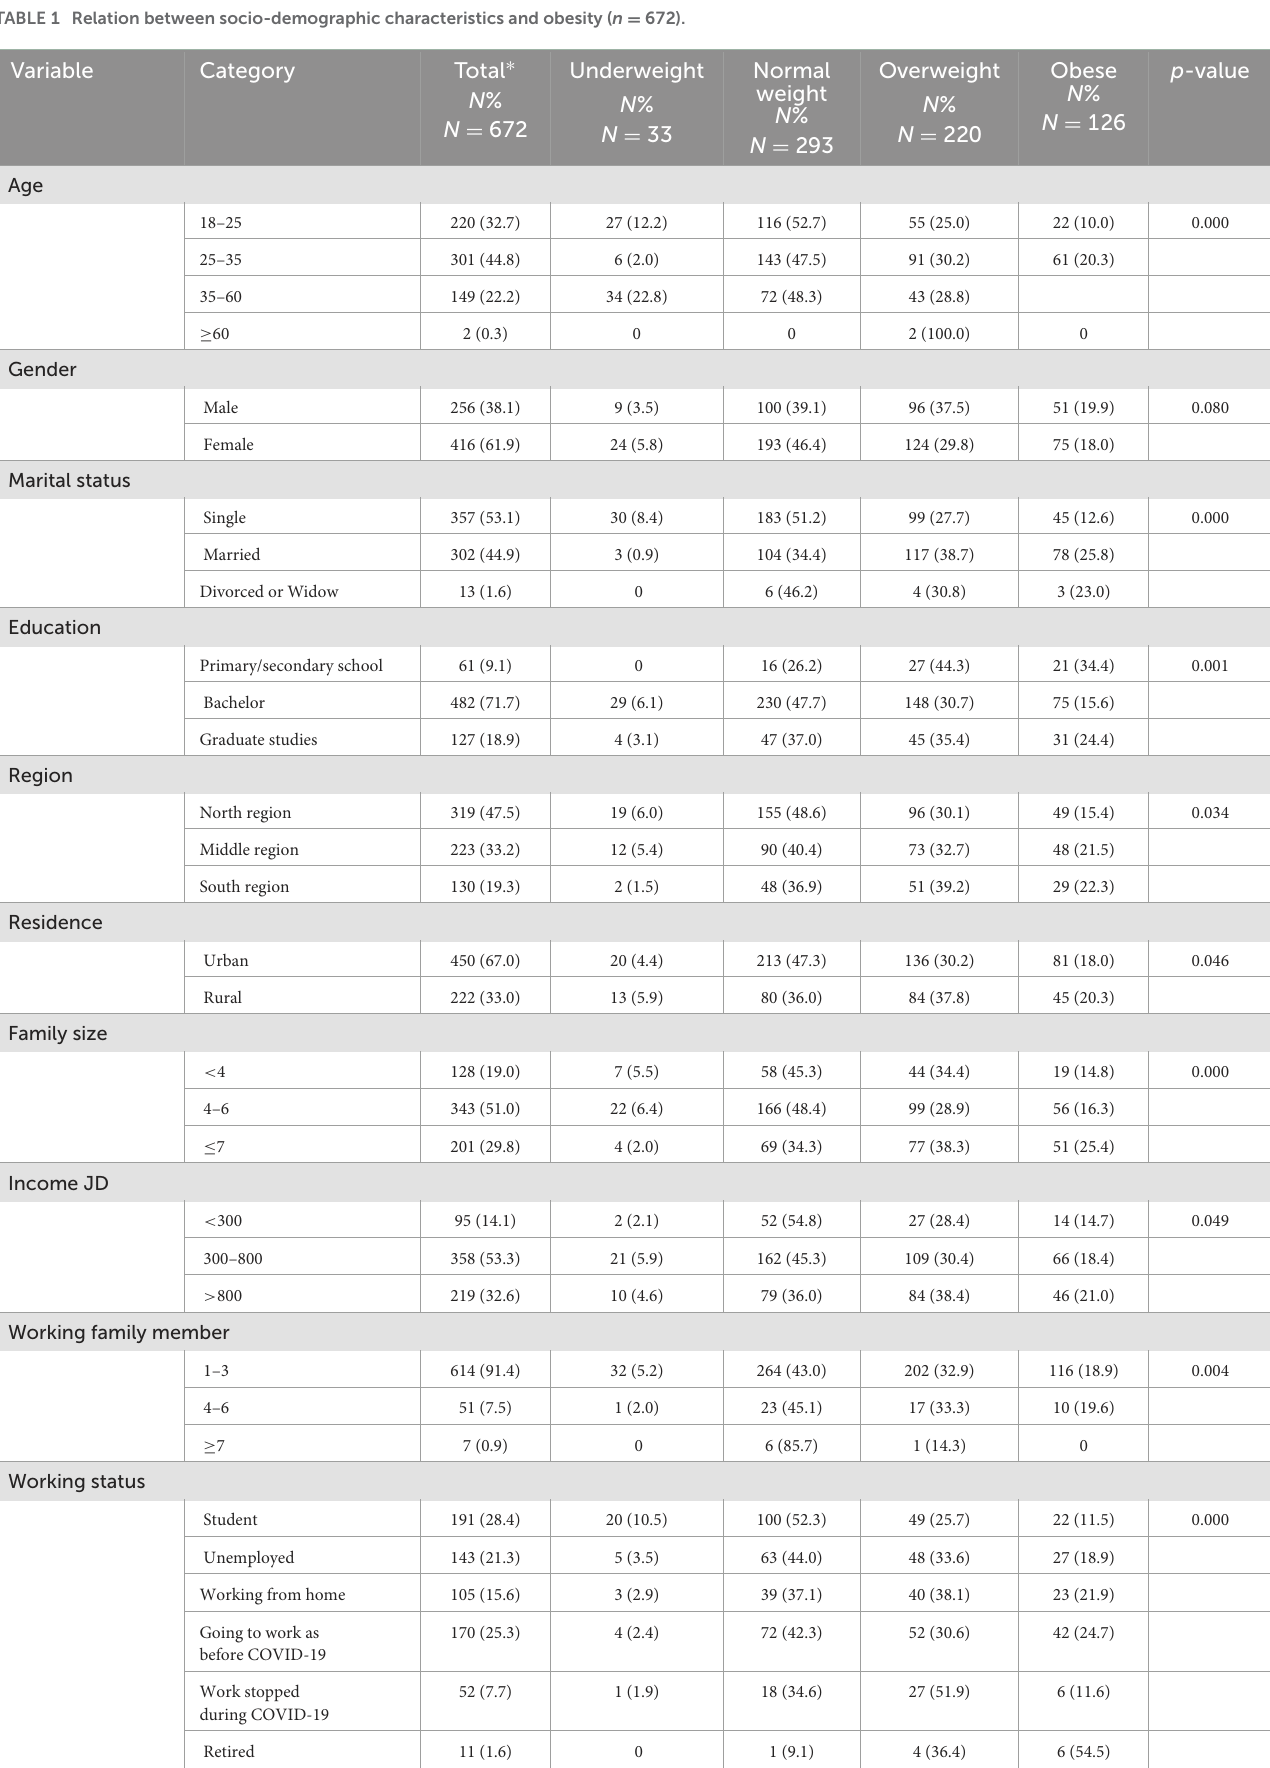
TABLE 1 Relation between socio-demographic characteristics and obesity ( n = 672).